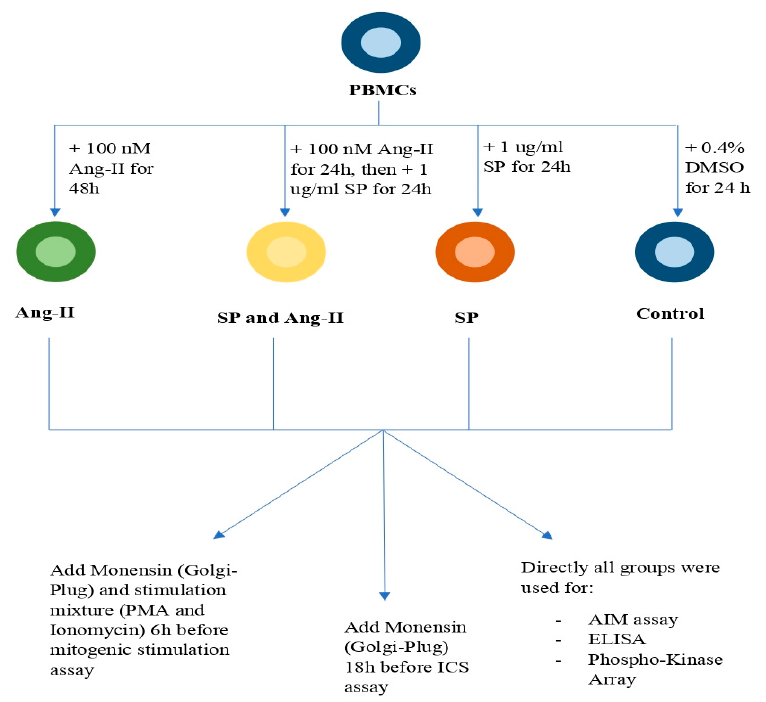
Figure 8. Protocol summary. Activation-induced cell marker assay (AIM); angiotensin II (Ang II); dimethyl sulfoxide (DMSO); enzyme-linked immunosorbent assay (ELISA); intracellular cytokine staining (ICS); peripheral blood mononuclear cells (PBMCs); phorbol 12-myristate 13-acetate (PMA); SARS-CoV-2 peptide pool